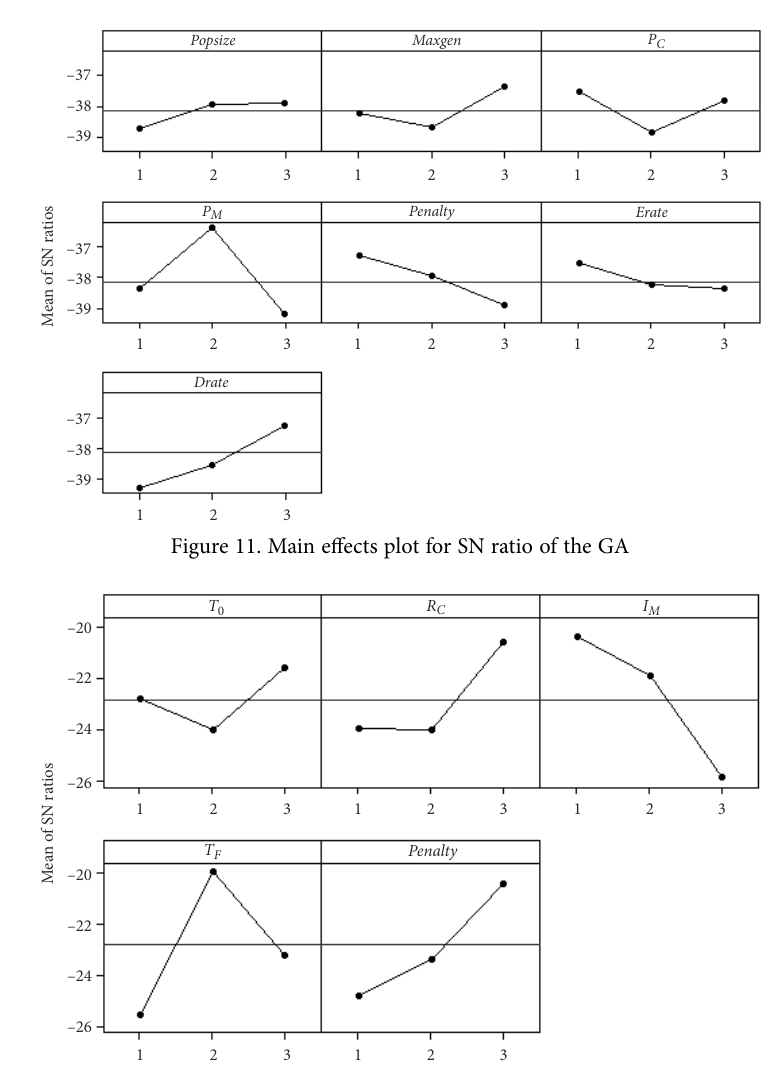
Figure 12. Main effects plot for SN ratio of the